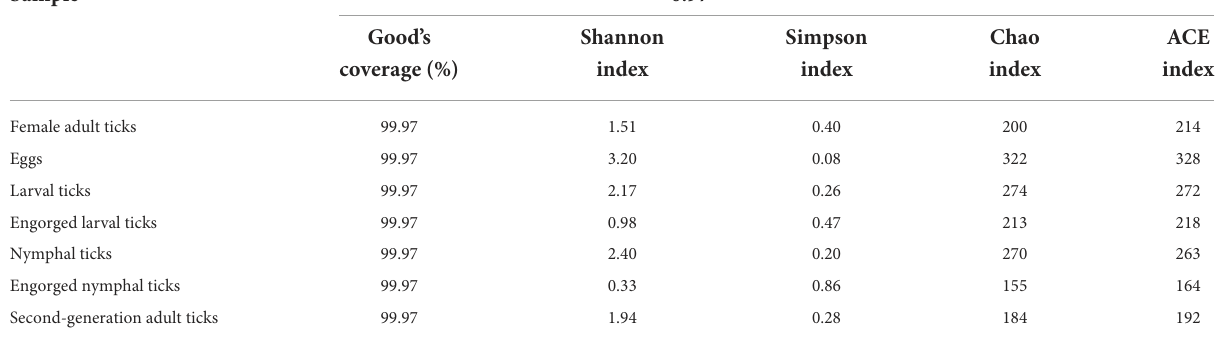
TABLE 3 Community richness and alpha-diversity indices of the